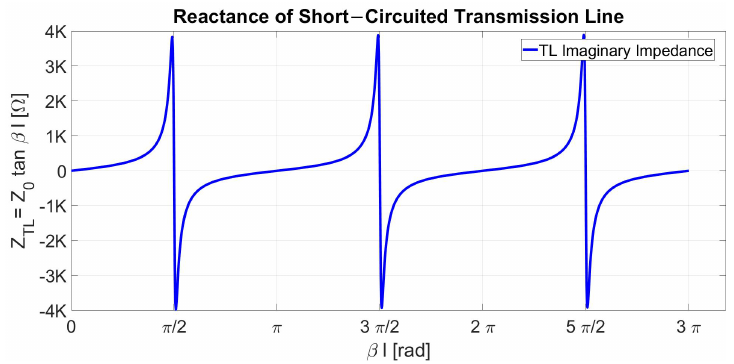
Figure 1. Reactance profile of Short−Circuited lossless Line [20]. Table 2. Reactance range of Short−Circuited lossless Line [20].